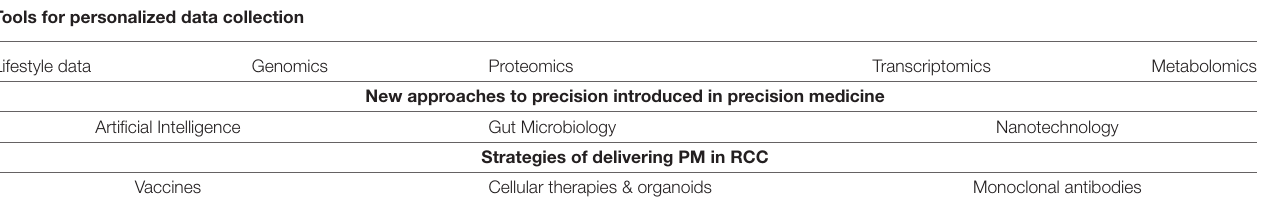
TABLE 2 | Summary of applications of precision medicine (PM) to facilitate treatment of patients with renal cell cancer (RCC). Tools for personalized data